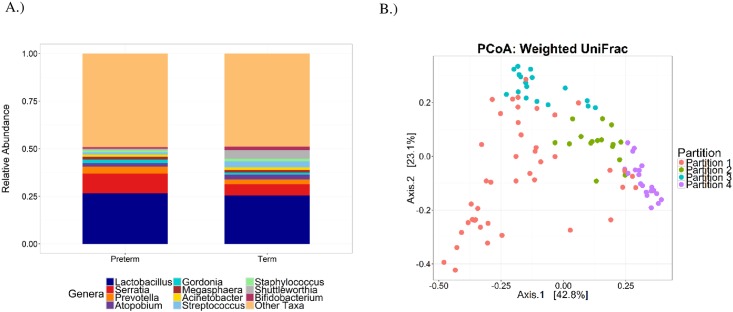
Urinary microbiota community composition.(A) Abundant genus-level phylotypes according to delivery status. (B) Principal coordinates ordination of the weighted UniFrac metric (variance axis 1 = 42.8%, variance axis 2 = 23.1%; p<0.001) for clustering by partitions identified from the Dirichlet multinomial model.